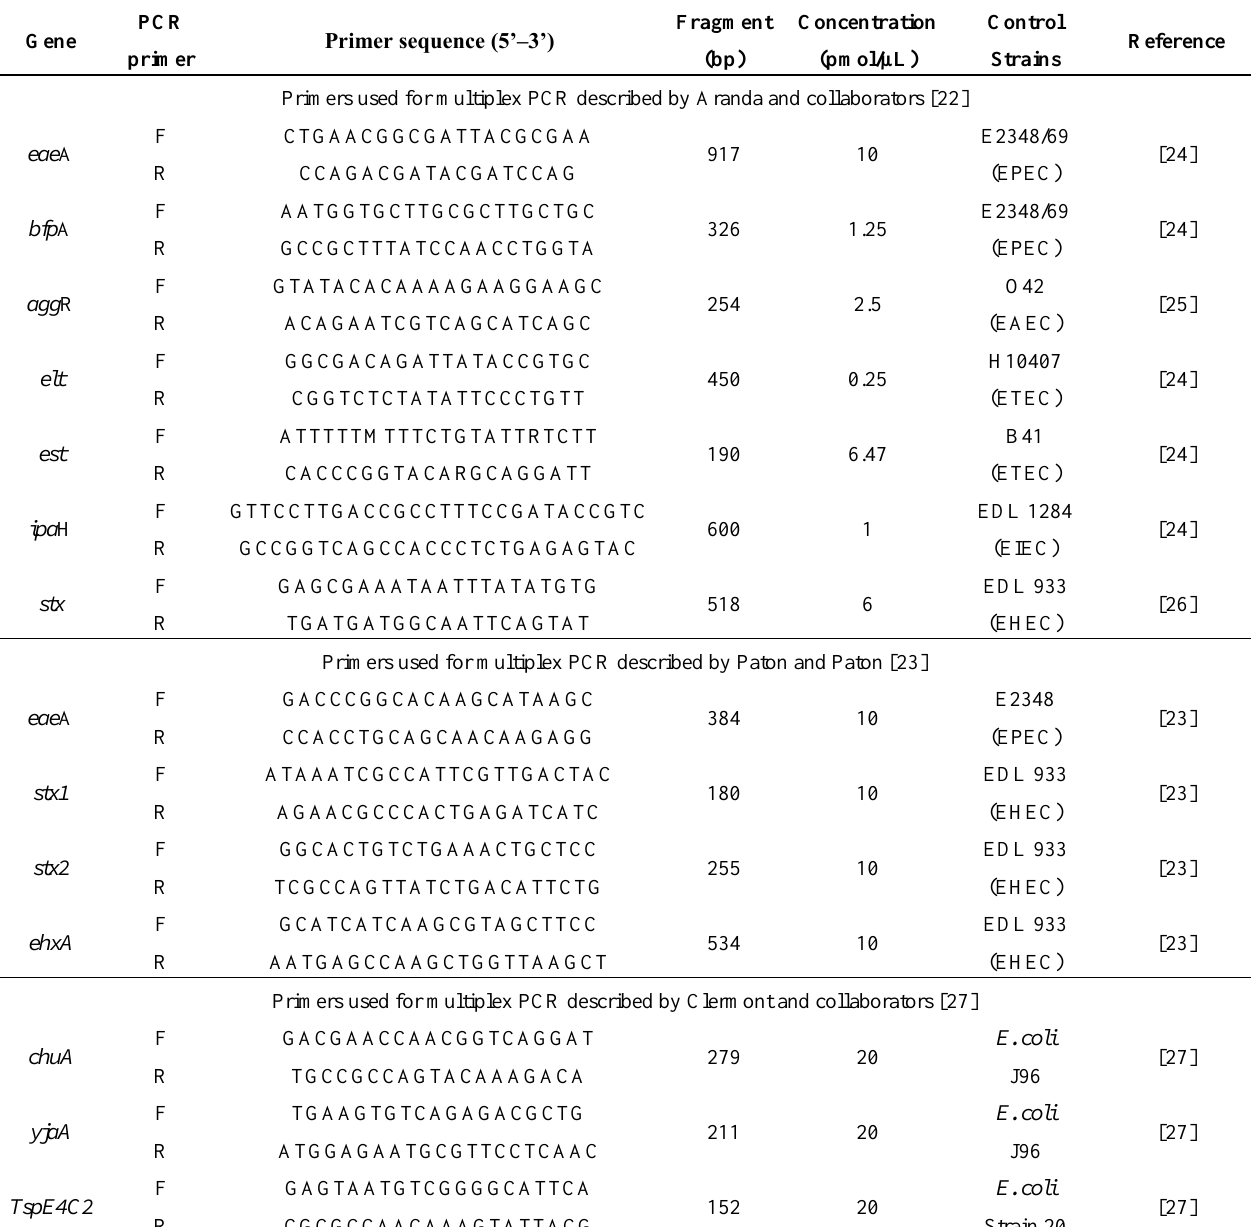
Table 1. PCR primers used in this